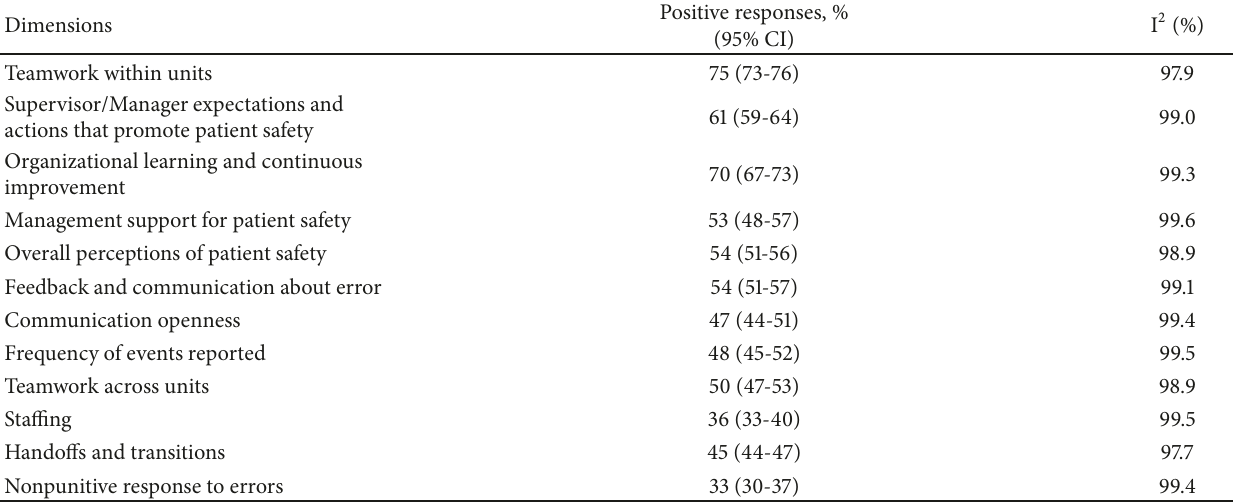
Table 3: Meta-analyses of the dimensions and respective heterogeneity (I 2 ) of the Hospital Survey on Patient Safety Culture (n=59 studies).